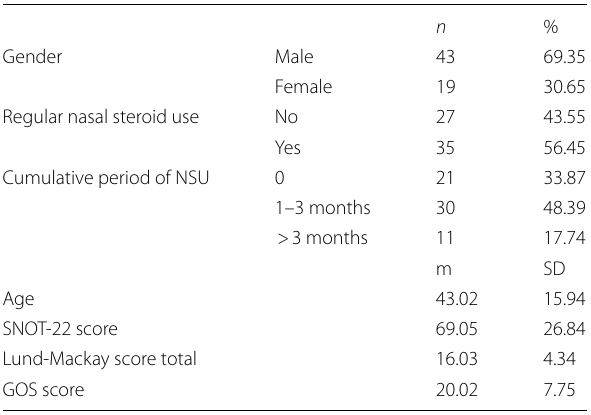
SD) deviations of outcome +